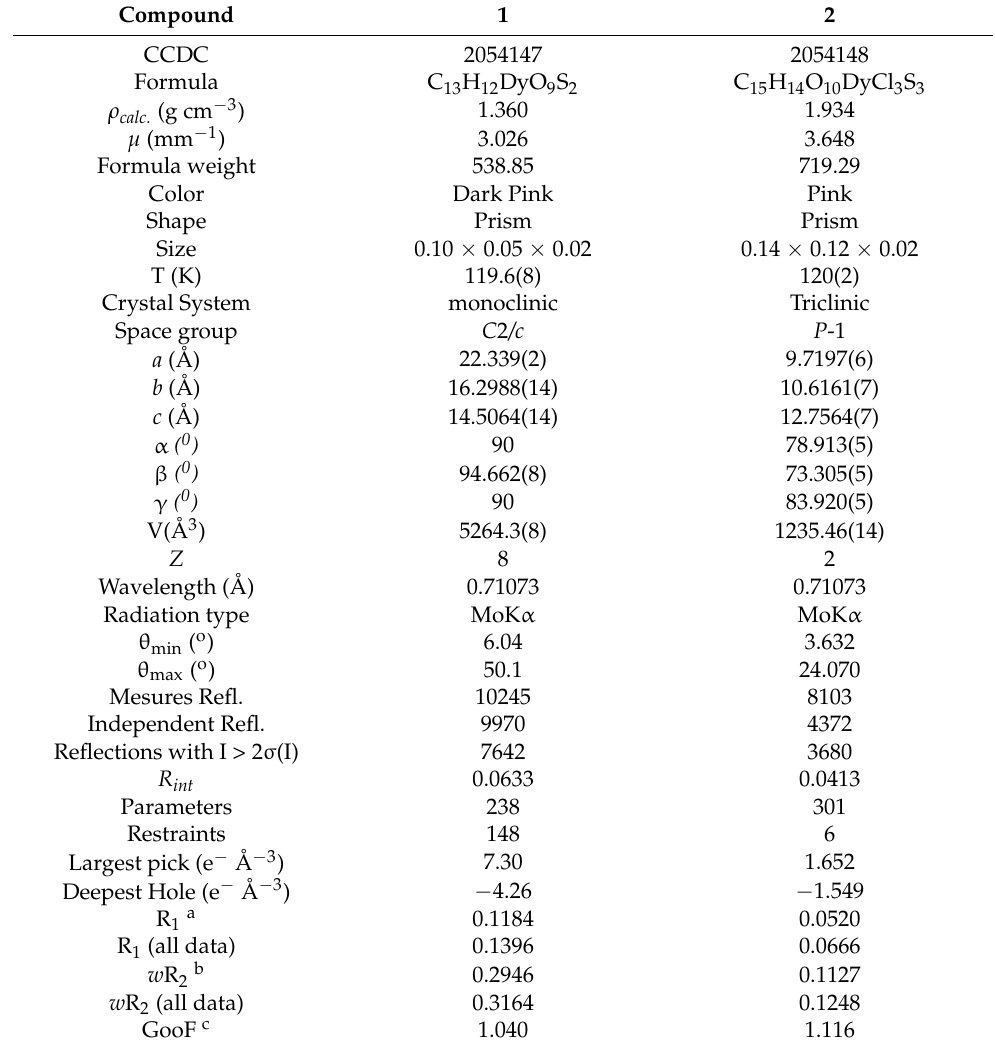
Table 3. X-ray crystal data collection for compounds [Dy 2 (C 6 O 4 H 2 ) 3 (dmso) 2 (H 2 O) 2 ] · 2dmso · 18H 2